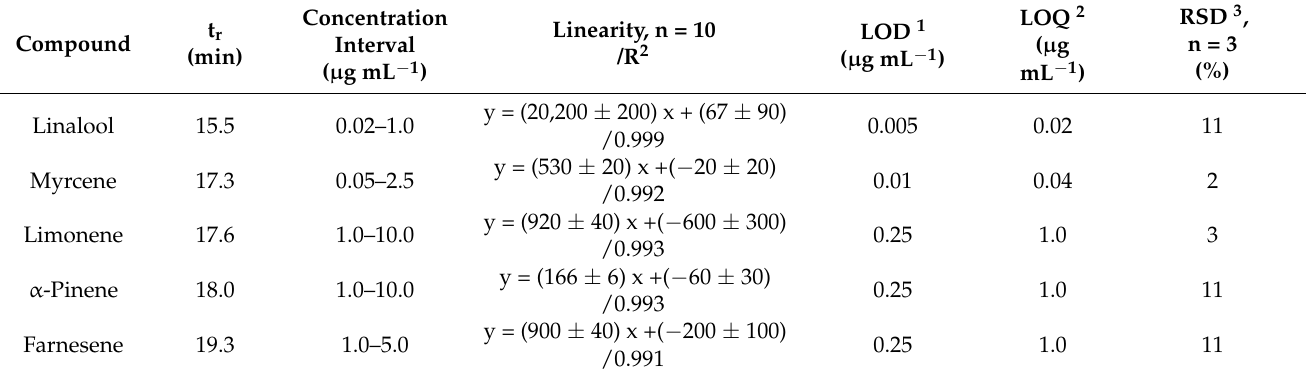
Table 2. Times of retention (t r ) and analytical parameters obtained with the proposed method.